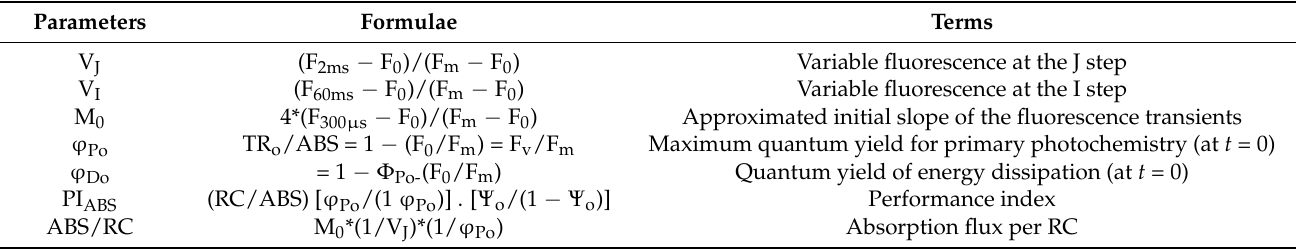
Table 5. Parameters, formulae, and terms used in the OJIP test (adapted from [39]). Parameters Formulae Terms Variable fluorescence at the J step Variable fluorescence at the I step Approximated initial slope of the fluorescence transients Maximum quantum yield for primary photochemistry (at t = 0) Quantum yield of energy dissipation (at t =